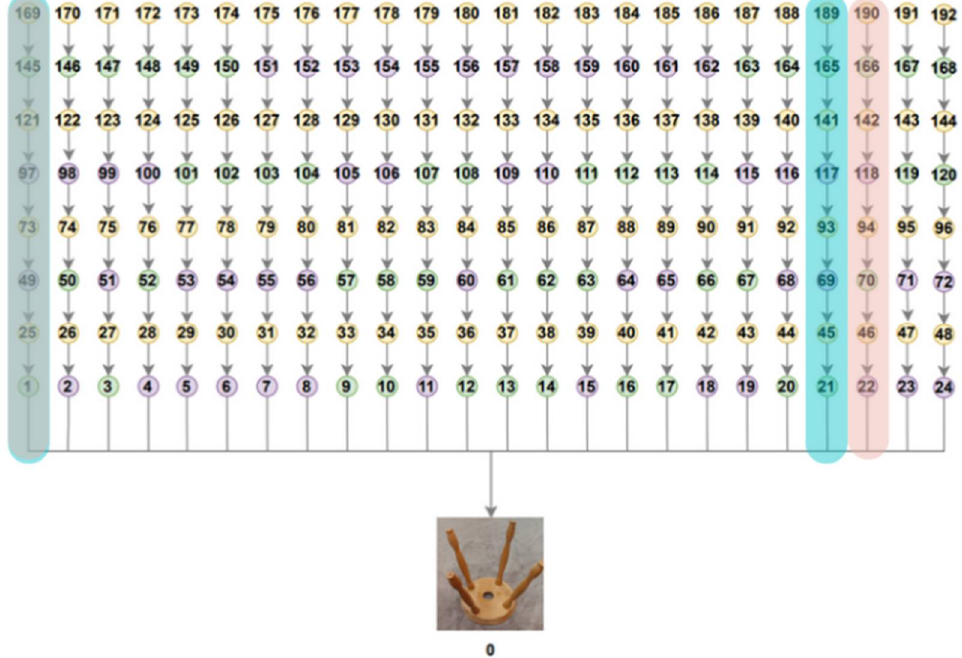
Figure 17. Generation of an ID Map.